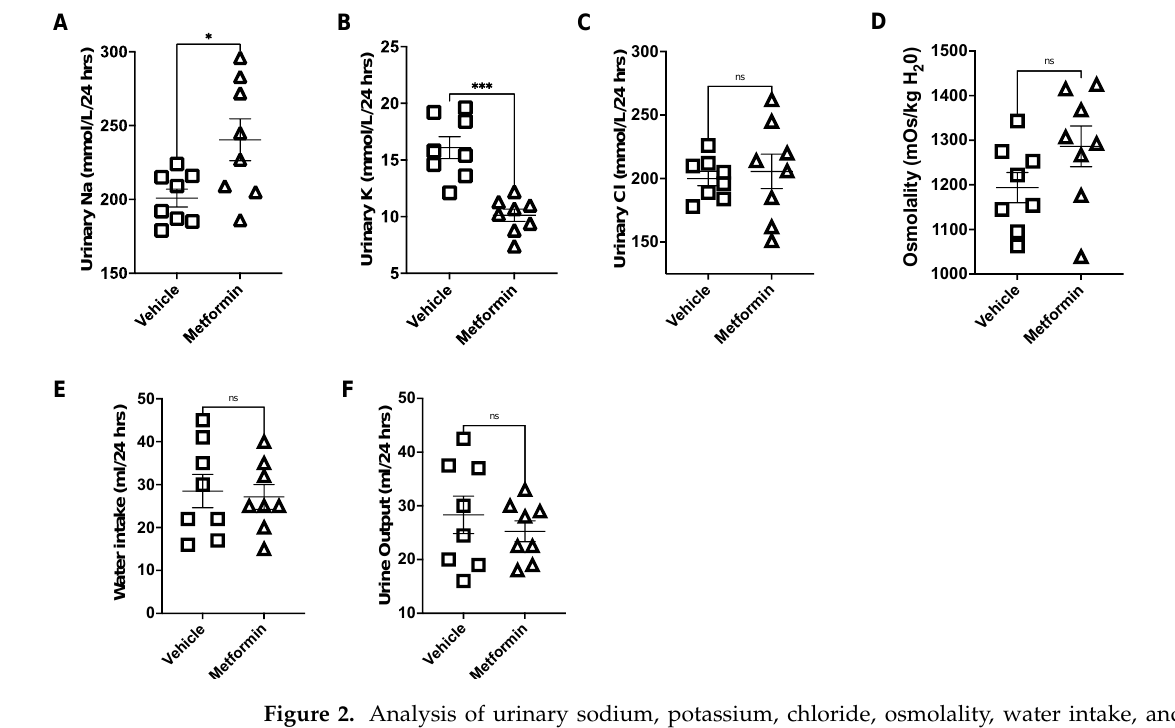
Figure 2. Analysis of urinary sodium, potassium, chloride, osmolality, water intake, and urine output from vehicle- or metformin-treated db/db mice maintained on an HSD. ( A ) Urinary sodium (mmol/L/24 h); ( B ) urinary potassium (mmol/L/24 h); ( C ) urinary chloride (mmol/L/24 h); ( D ) urinary osmolality (mOsm/Kg H20); ( E ) water intake (ml/24 h); ( F ) urine output (ml/24 h). N = 8. Data are plotted as mean ± SEM, * represents a p -value < 0.05, and *** represents a p -value < 0.001. ns: not significant.